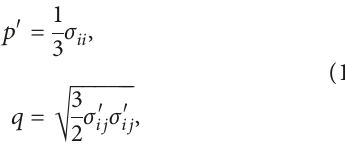
Figure 16: Evolution of a : (a) reference group; (b) composite pattern group; (c) unbreakable c